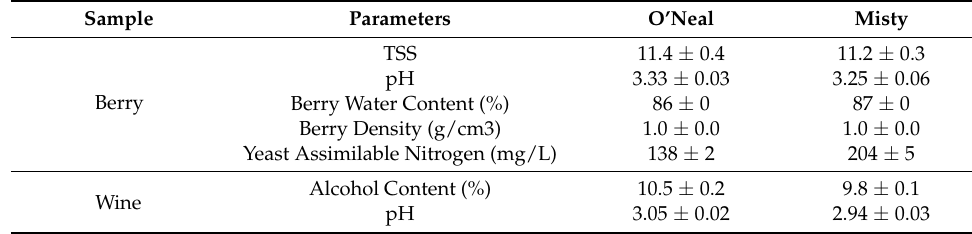
Table 1. Basic parameters for fruit and wine samples in this study. Mean ± SD presented (n =